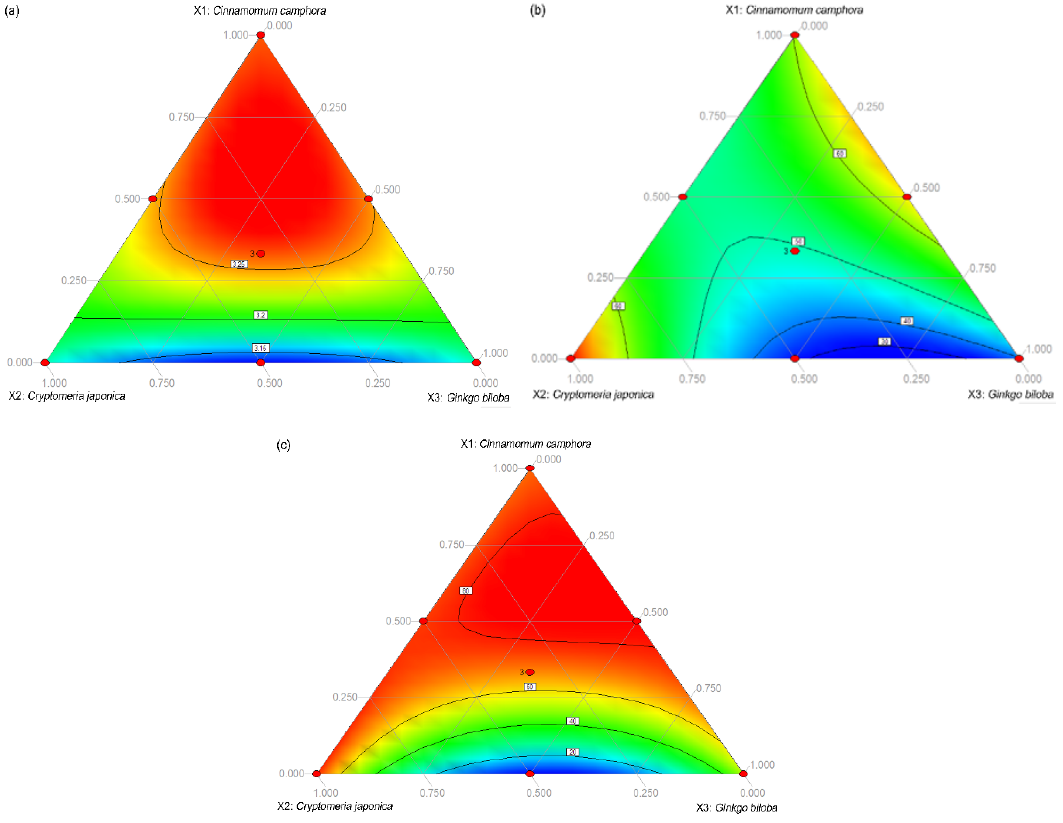
Figure 2. Response surface contour plots for the ( a ) antioxidant, ( b ) anti ‐ tyrosinase, and ( c ) anti ‐ elastase activities of different compositions of X 1 (CC), X 2 (CJ), and X 3 (GB).